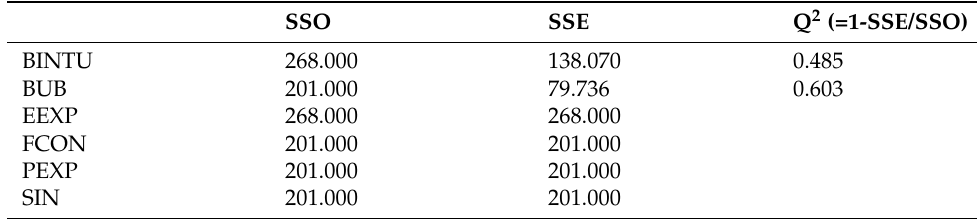
Table 11. Construct cross-validated redundancy.